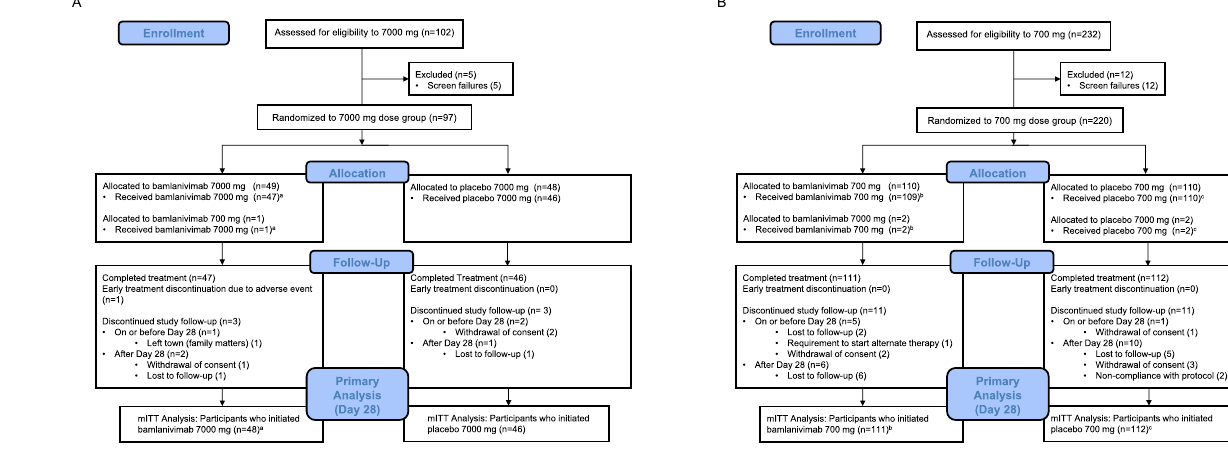
Fig. 1| CONSORT fl owdiagramforeachbamlanivimabdosecohort.A 7000mg dose cohort and B 700mg dose cohort. a Of the n =48 participants that